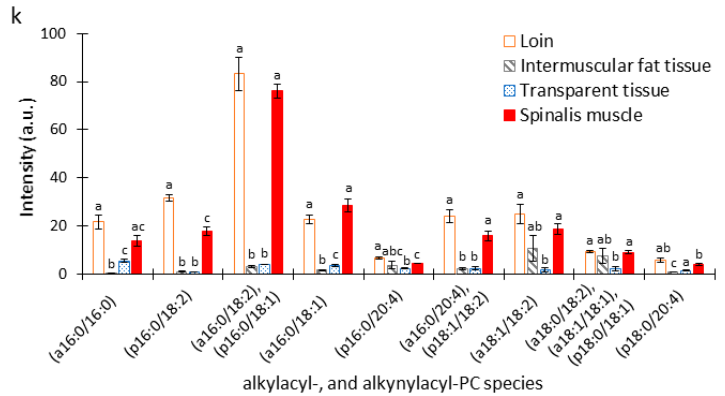
Figure 5. MALDI-MSI analysis of alkylacyl- and alkenylacyl-phosphatidylcholine (PC) species in pork chop sections. ( a ) Optical image of pork chop section prior to MALDI–MSI analysis. ( b – j ) Representative ion images arranged according to their fatty acid compositions. Fatty acid compositions at the sn-1 position are arranged along the x-axis, and those at the sn-2 position are arranged along the y-axis. In the sn-1 position, ‘e’ and ‘v’ indicate ether and vinyl-ether bonds, respectively; therefore, green and red represent alkylacyl- or alkenylacyl-PC species, respectively. Scale bar represents 2 mm. ( k ) Intensities of alkylacyl- and alkenylacyl-PC species in longissimus thoracis et lumborum muscle (loin), intermuscular fat tissue, transparent tissue, and spinalis muscle using MALDI-MSI. The data are expressed as the mean ± standard deviation ( n = 3). Mean values with different letters indicate significant differences ( p < 0.05) as determined by Dunnett’s T3 multiple comparisons test.